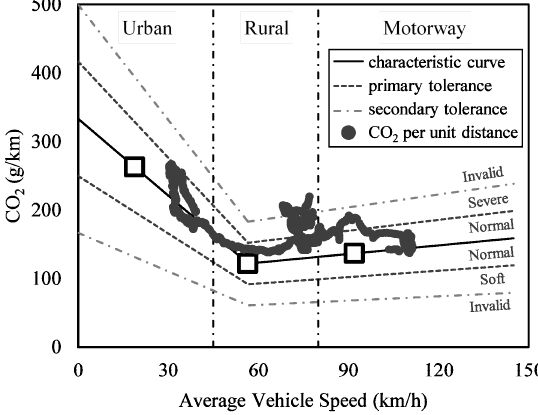
Figure 2. CO 2 emissions per unit distance and CO 2 characteristic curve.